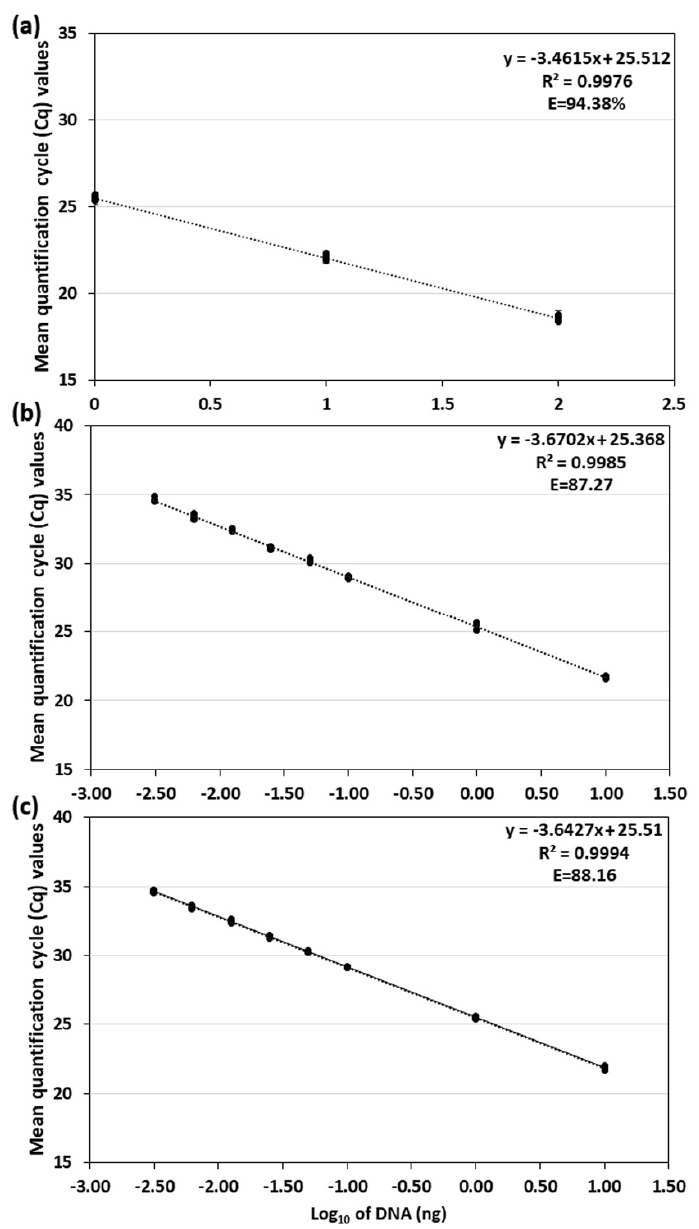
Figure 1. Standard curves for DpinodellaTef primer and probe set generated from qPCR assays in this study. Panel ( a ) represents the linear standard curve and the assay performance averaged over five separate qPCR reactions (each performed with two technical replicates) generated in the primer and probe set validation experiments using 10-fold dilution series of D. pinodella genomic DNA ranging from 1 to 100 ng (see Table S2 for detailed results); Panels ( b , c ) show linear standard curves and the assay performance for the ≤ 35 quantification cycles threshold generated for simplex ( b ) and duplex ( c ) qPCR assay used to determine limits of detection (LOD) and quantification (LOQ) of the pathogen DNA in plant tissue. The LOD and LOQ were evaluated for dilution series of D. pinodella genomic DNA ranging from 2.5 × 10 − 5 to 10 ng (each in 4 or 8 replicates) made in DNA extract of healthy pea roots (see Table S3 for detailed results). The Cq values are plotted against the DNA concentrations expressed on a logarithmic scale. The error bars were too small to illustrate.